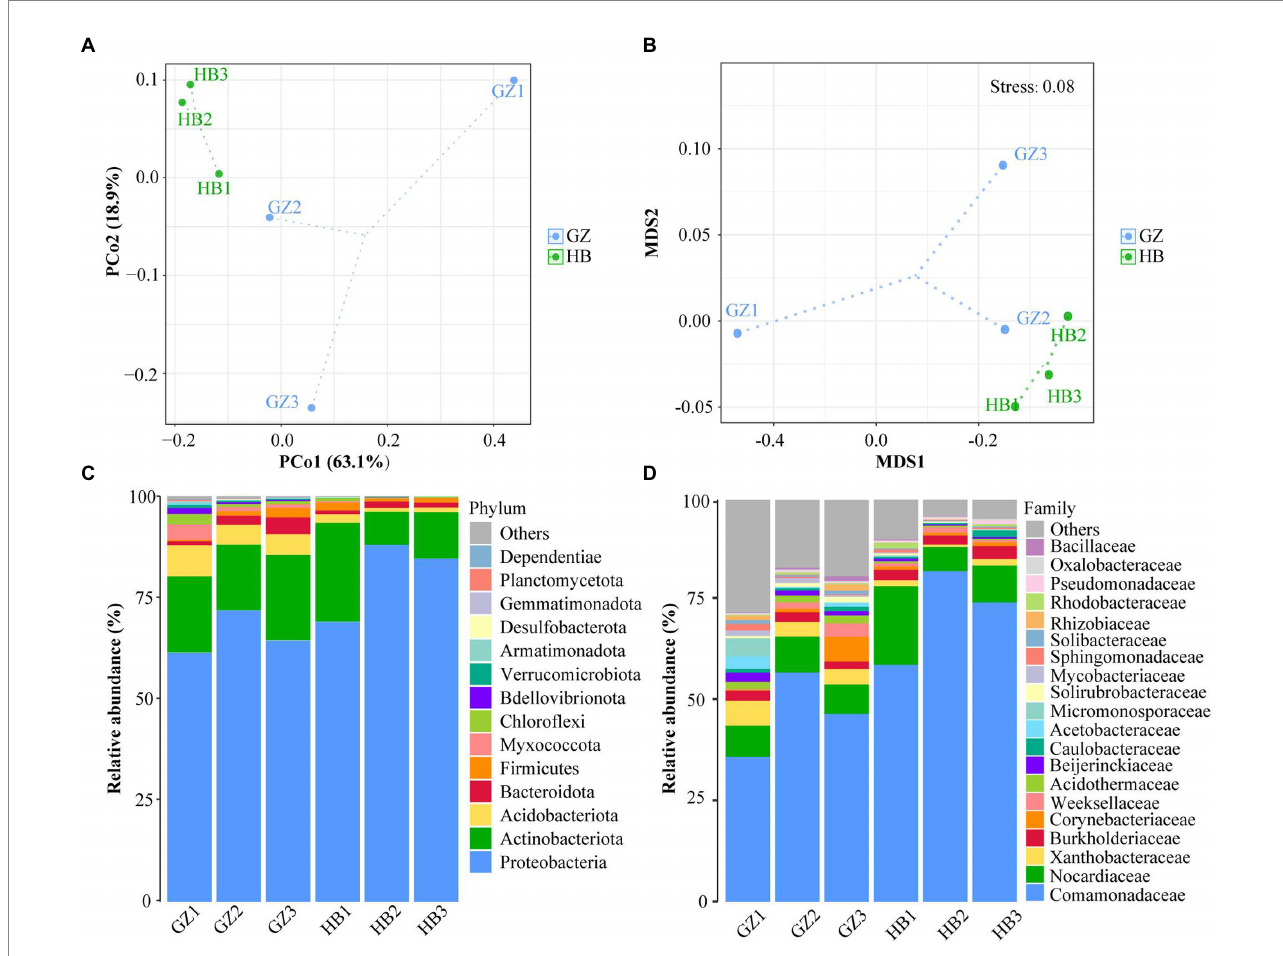
FIGURE 3 Composition of endophytic bacteria in Gastrodia elata f.glauca tuber samples. (A) Multiple sample principal coordinate analysis (PCoA) of the ASV level. (B) Multiple sample Non-metric multidimensional scaling (NMDS) of the ASV level. (C) Relative abundance of phyla in each sample. (D) Relative abundance of family in each